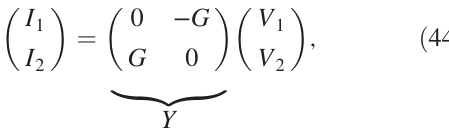
FIG. 10. Circuit design implementing the Hamiltonian in Eq. (46), which approximates the GKP